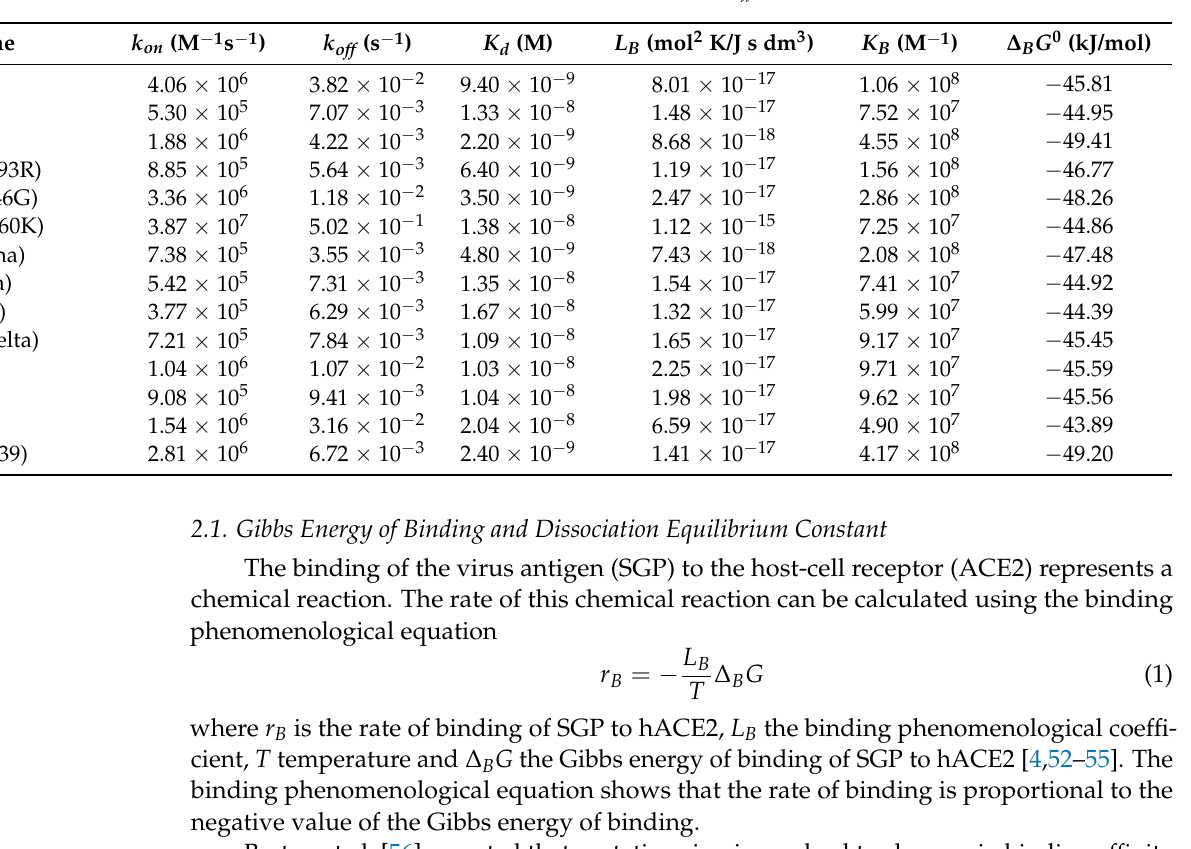
Table 1. Standard thermodynamic properties of the binding of SARS-CoV-2 variants. The table shows the association rate constant, k on , dissociation rate constant, k off , dissociation equilibrium constant, K d , binding phenomenological coefficient, L B , binding equilibrium constant, K B , and standard Gibbs energy of binding, ∆ B G 0 ; data taken at 25 ◦ C. The k on , k off , and K d data were taken from ref.